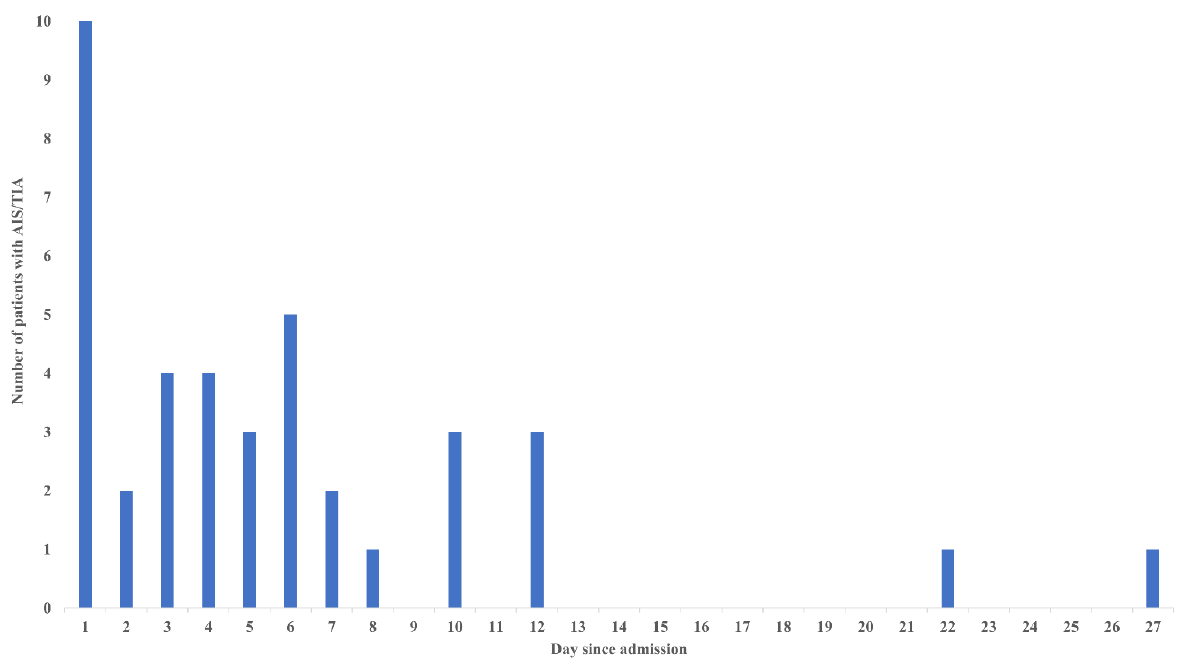
Figure 2. The distribution of the onset-day of AIS/TIA. The peak period of the occurrence of AIS/TIA was within 24 h of admission. Abbreviations: AIS = acute ischemic stroke, TIA = transient ischemic attack.